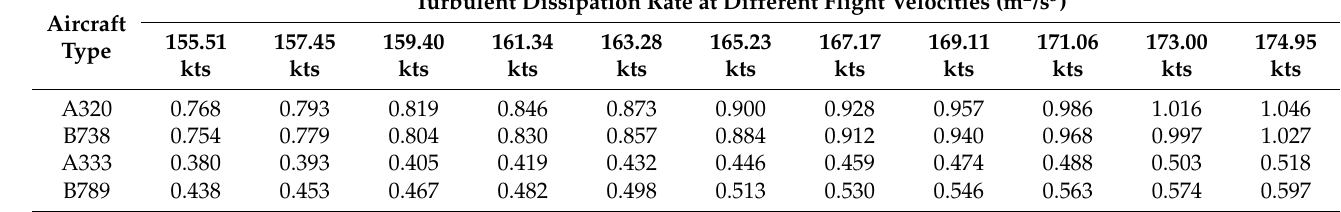
Table 3. Turbulent dissipation rate of each aircraft at different velocities.